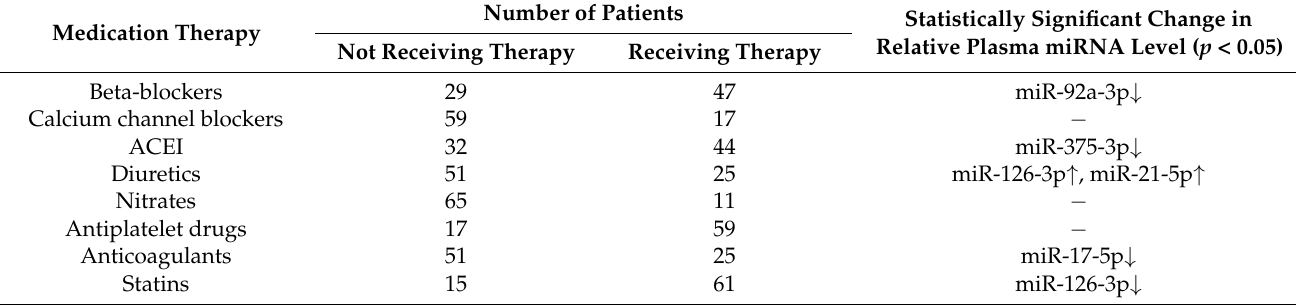
Table 4. Results of relative plasma miRNA level comparisons between groups receiving or not receiving specific medication therapies, using the Mann–Whitney test, within the combined SCAD + ACS group (n = 74). ↓ and ↑ symbols indicate lowered and elevated relative miRNA plasma levels in patients receiving therapy compared to patients not receiving therapy,